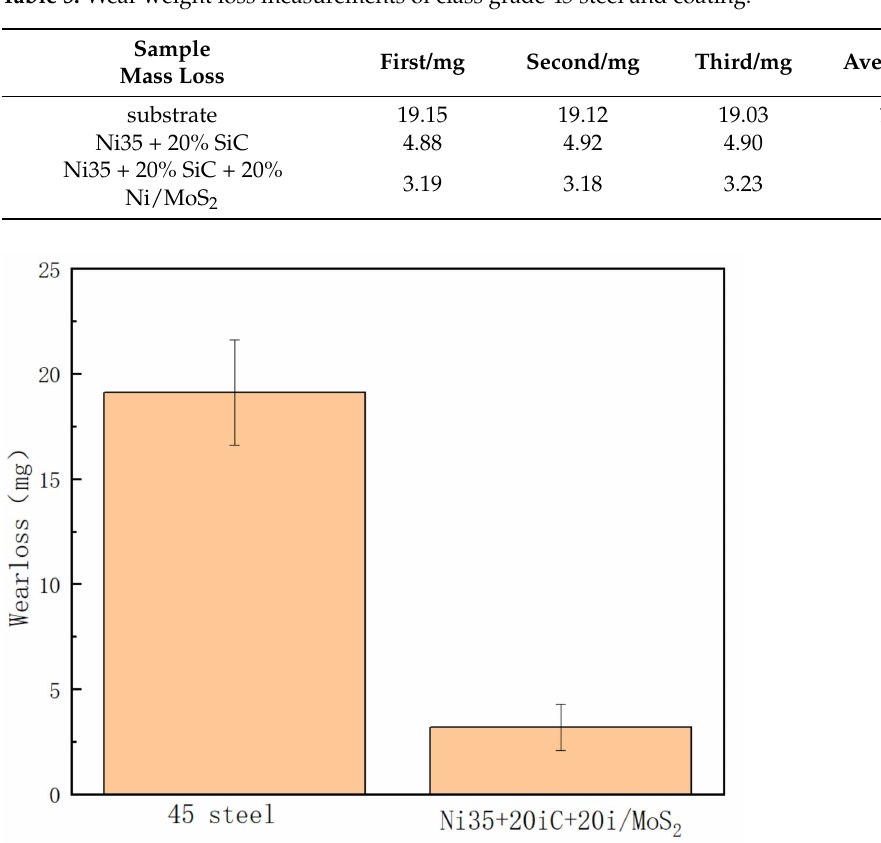
Table 5. Wear weight loss measurements of class grade 45 steel and coating.